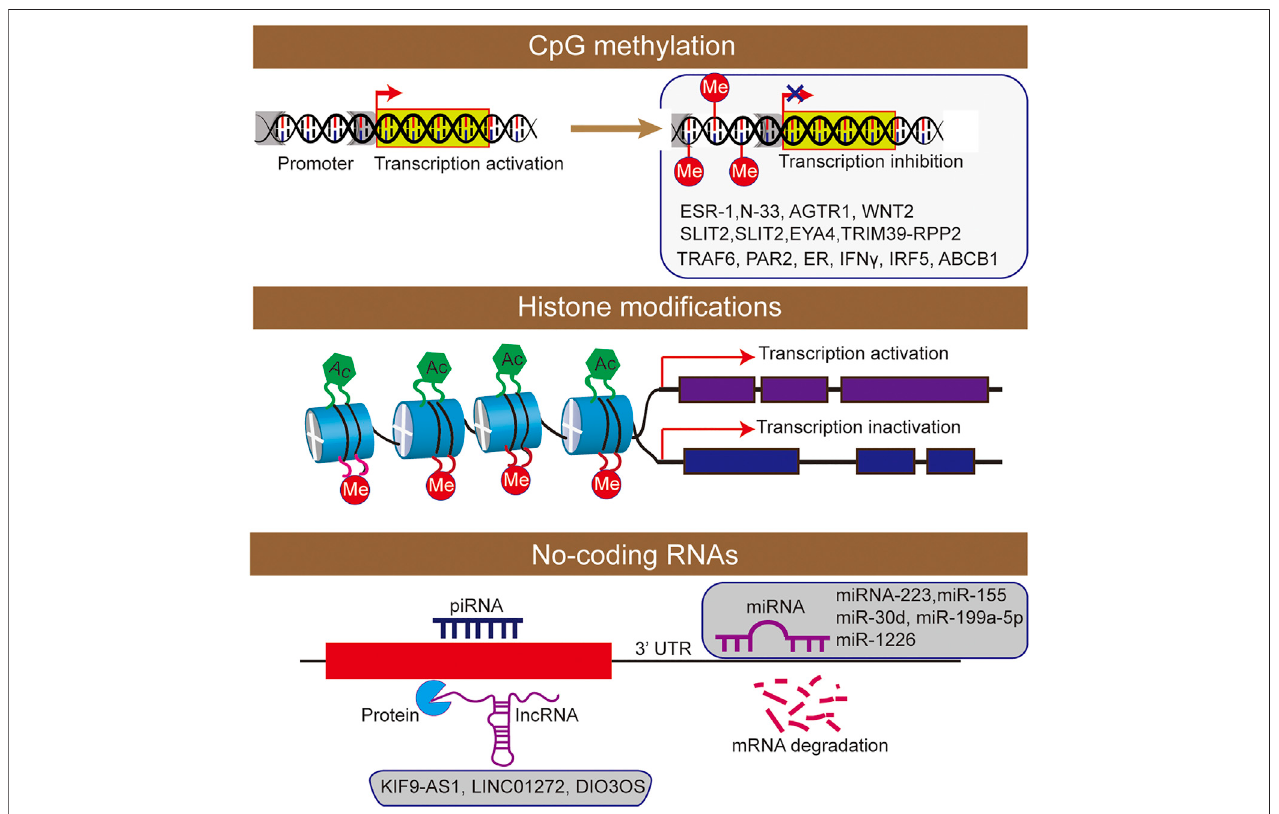
FIGURE 2 | The epigenetic machinery consists of DNA methylation, histone modi fi cations short interfering RNA were participated the regulation of in fl ammatory bowel disease.